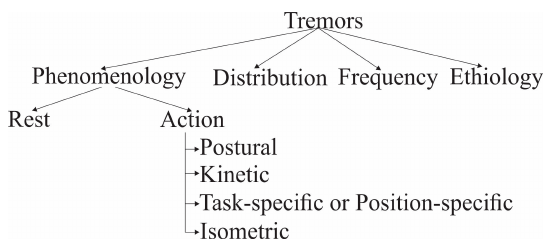
Figure 1. Tremor classification.